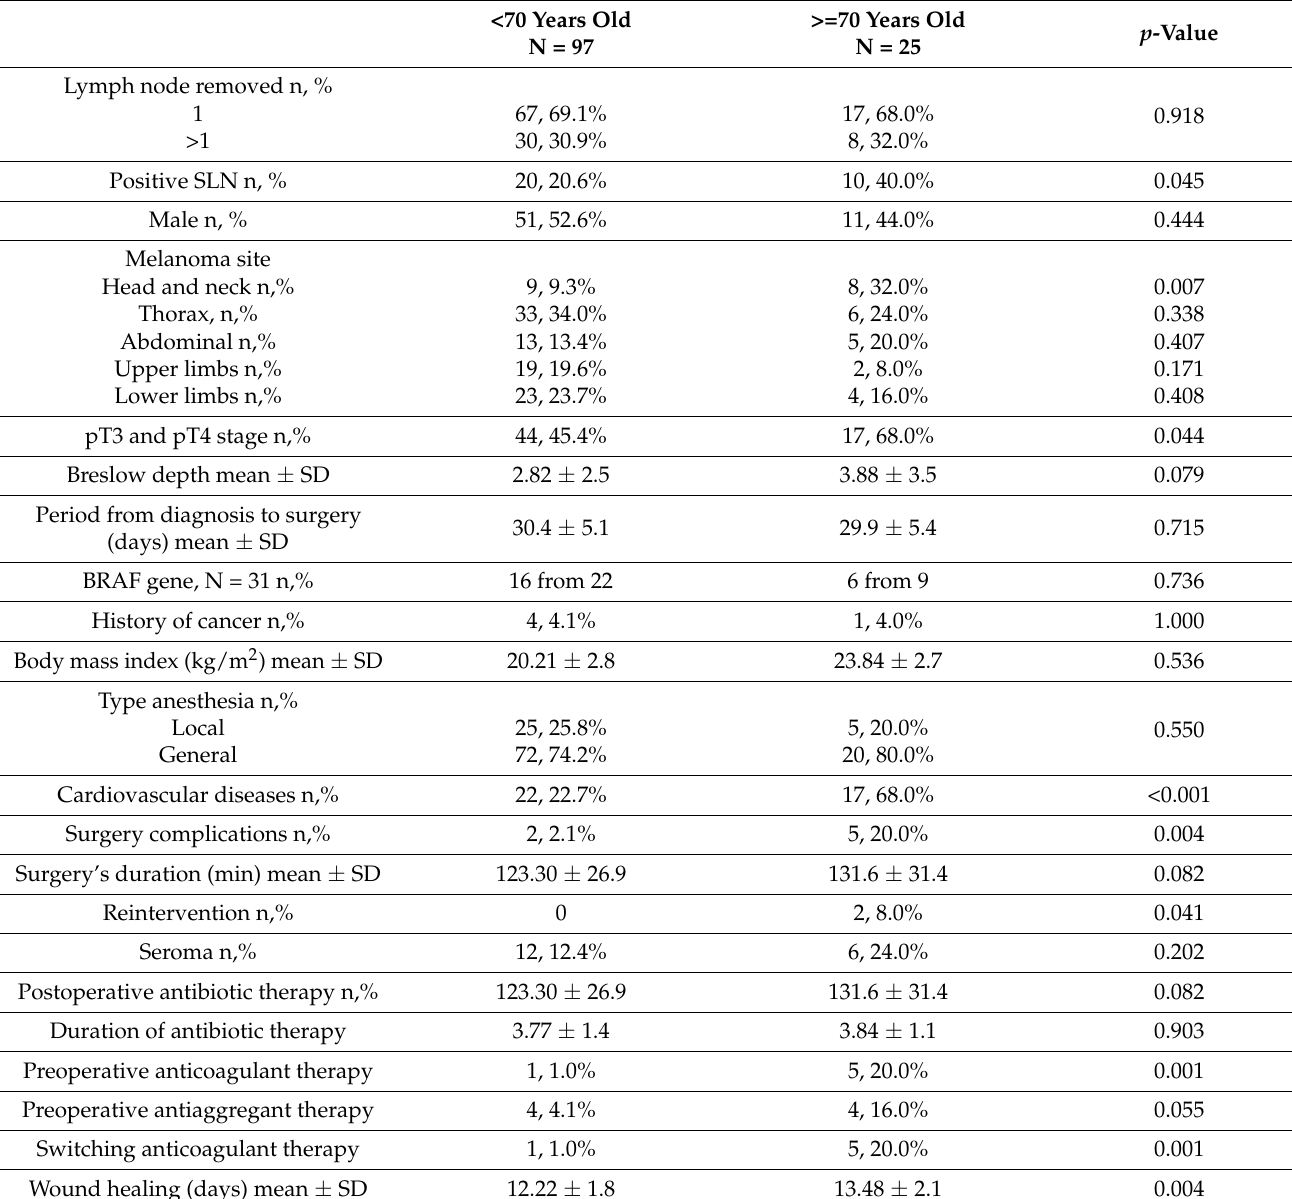
Table 3. Comparison depending on